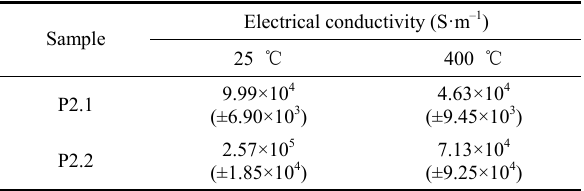
layers formed from pastes P2.1 and P2.2 after 5 h sintering at 1400